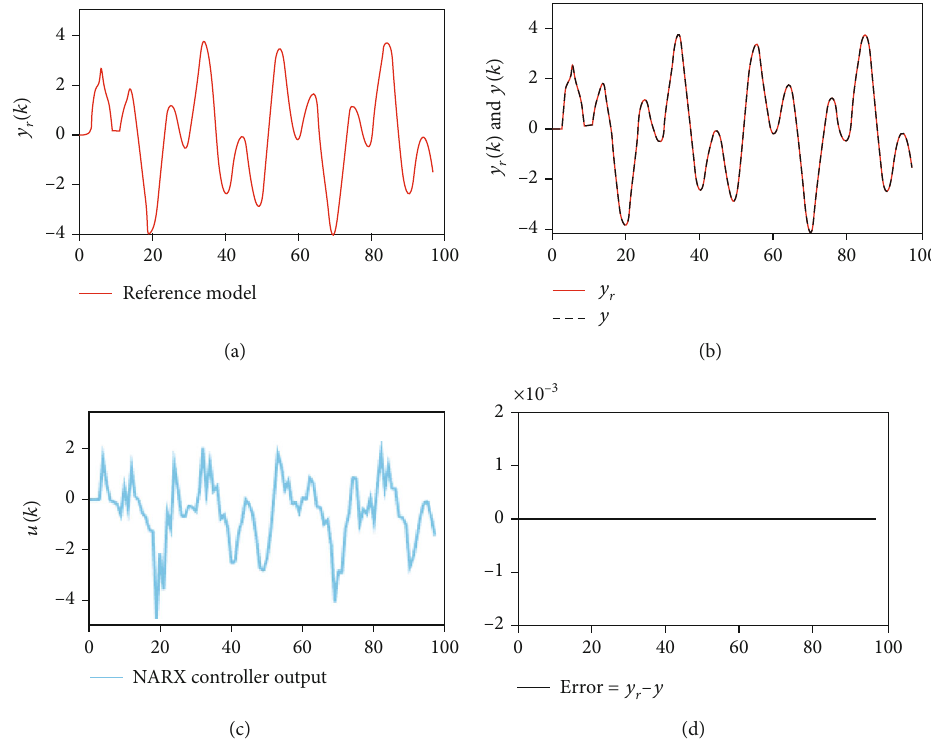
Figure 6: Example 1: (a) response of the reference model, (b) outputs of the reference model and the plant with control action, (c) NARX controller output, and (d) control error.